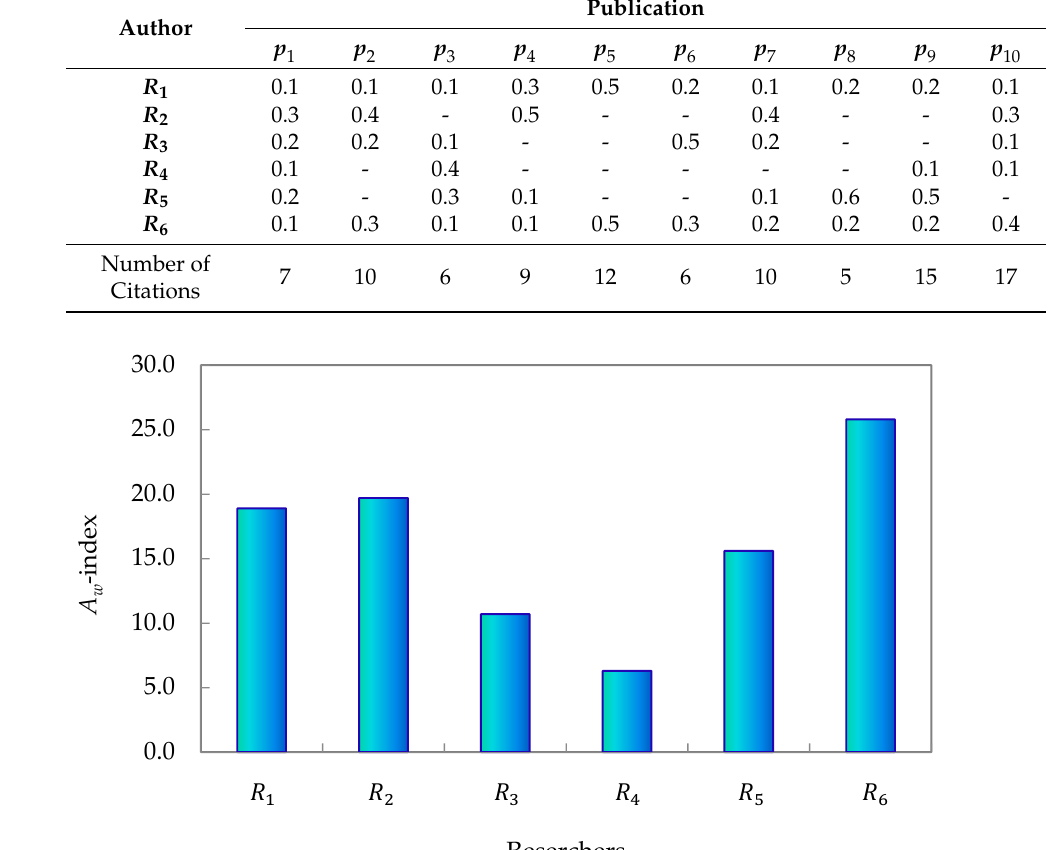
Figure 1. 𝐴 (cid:3050) -index of the six researchers considered for present study. Figure 1. A w -index of the six researchers considered for present